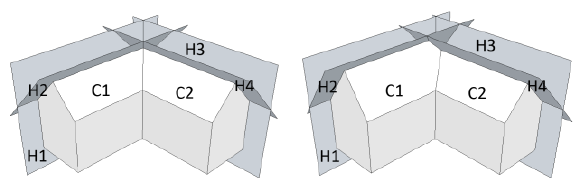
Figure 8. Modelling L-shaped intersections is performed by a pairwise interconnecting of half-spaces of the two components, which is independent of ridge